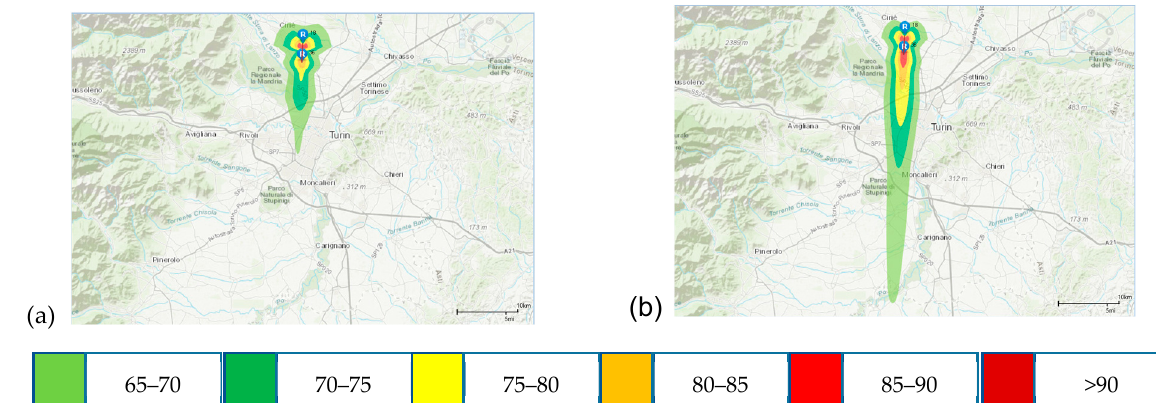
Figure 44. Graphical representation of equal loudness contours for the conventional ( a ) and hybrid ( b ) configurations, in terms of L AE (dB-A), for a standard runway-18 take-off.